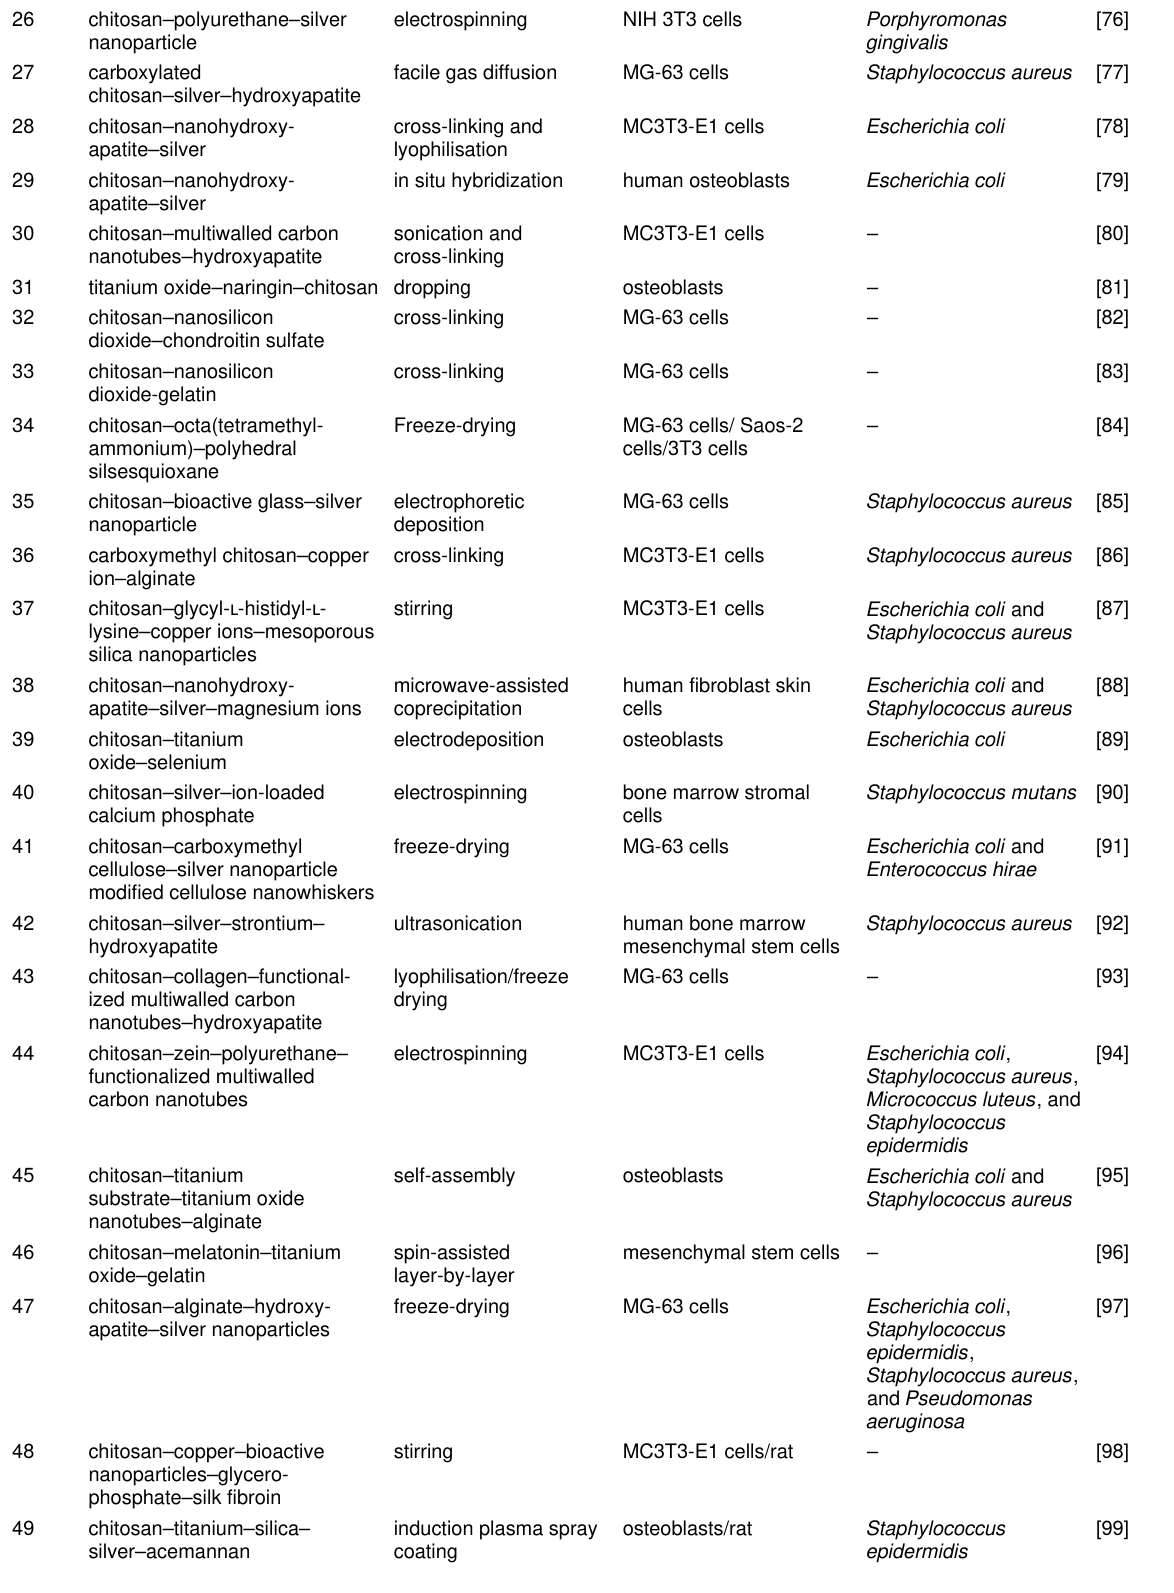
Table 1: Combinations of chitosan with several polymeric materials and nanoparticles to mimic the natural bone function. (continued)